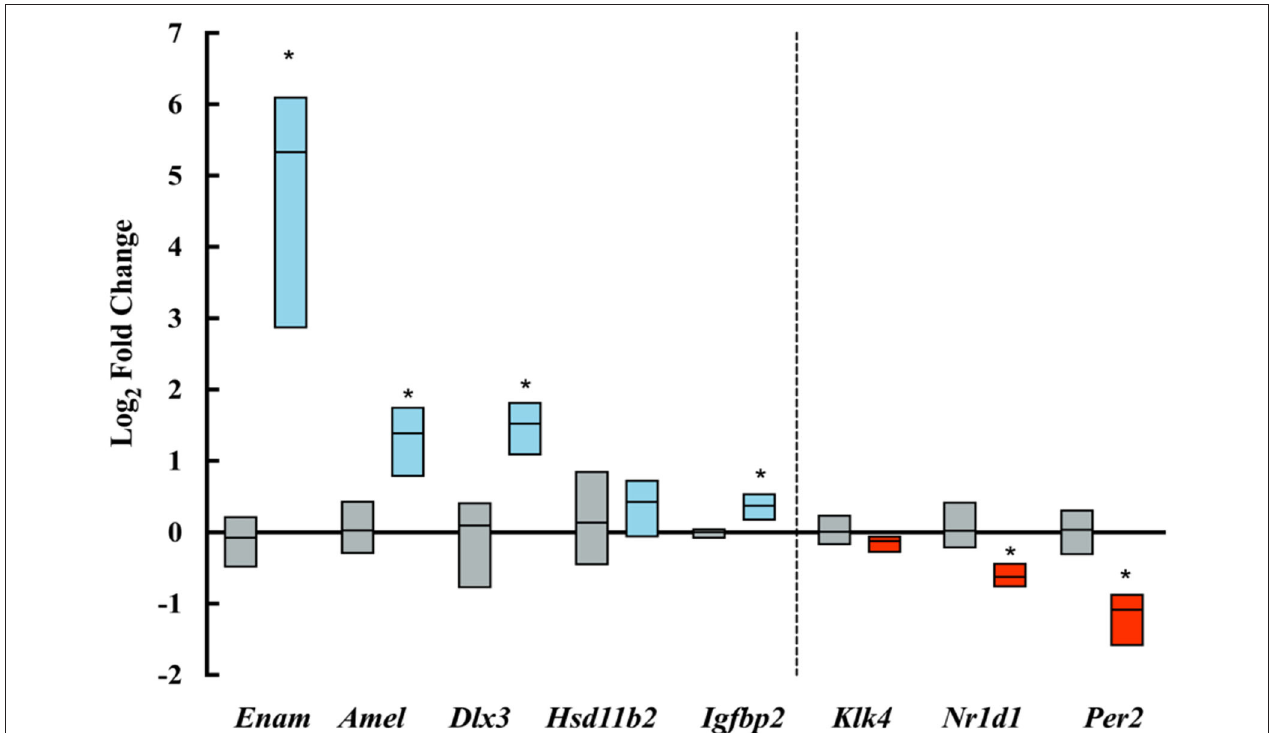
FIGURE 5 | Log-fold changes of transcripts amplified by qPCR. Blue boxes show upregulated transcripts and red boxes show downregulated transcripts expressed in ELA enamel organs as compared to controls (gray boxes). * p < = 0.05.